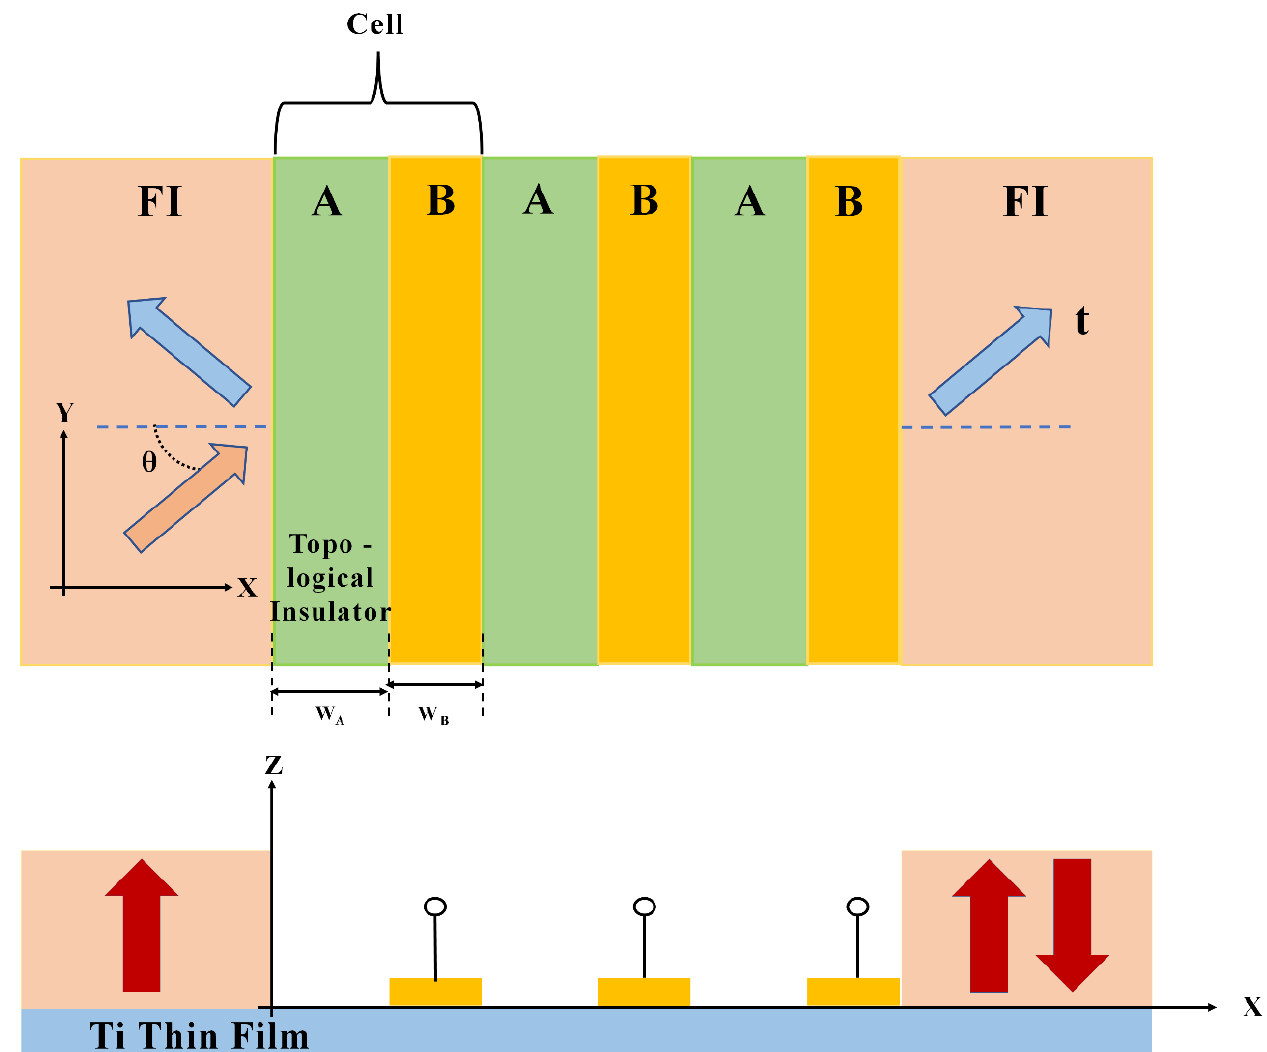
Figure 12. The TIs thin film spin valve with a 3-cell top gate is represented schematically in terms of its device profile. The unit cell (A/B) in this system is assumed to be the normal and top-gate potentials. The grey electrodes that represent the top gates on the TI surface provide squared gate voltages (Vg). The spin valve receives spin electrons at an incidence angle of (FI-ferromagnetic insulator) [101] (Copyright © 2021, The Author(s)).